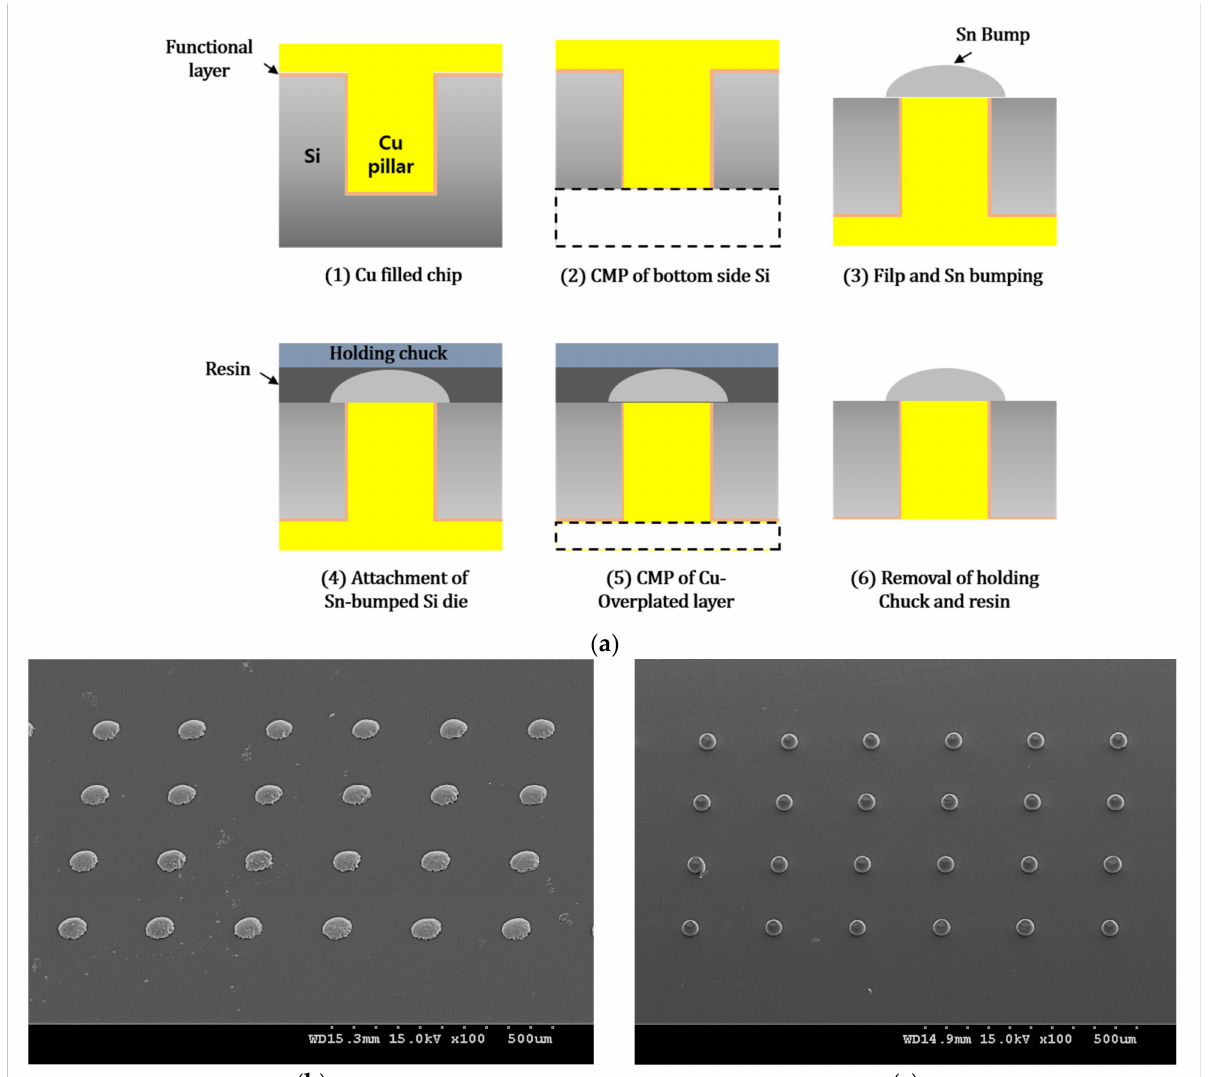
Figure 14. ( a ) Process flow for producing a non-PR bumping on a Si die by electroplating [79]; ( b ) Sn-3.5Ag bumps formed on the Cu plugs by non-PR bumping; ( c ) bump appearance after reflow.